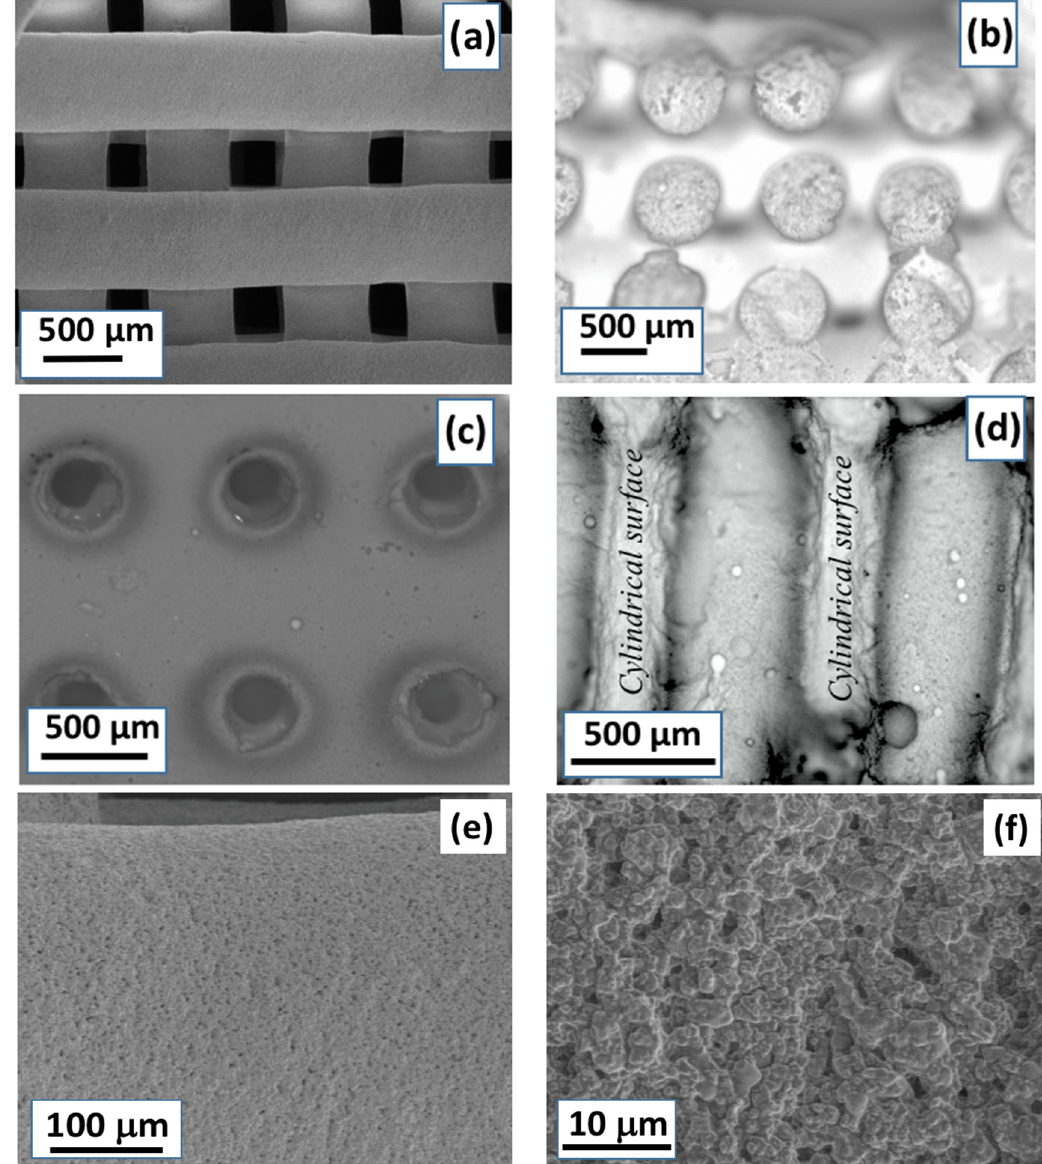
Figure 3. Micrographs show upper scaffold surfaces taken by SEM prepared from: ( a ) robocasting (RC) and ( c ) laser micromachining (LM). Images ( b , d ) were made using a confocal microscope and correspond, respectively, to cross-sectional areas of rods obtained by robocasting and axial- section area of the cylindrical pore cavity created by laser ablation (cylindrical surfaces); ( e , f ) SEM magnifications of the cylinder rod RC scaffold surface previously shown in Figure 3a.